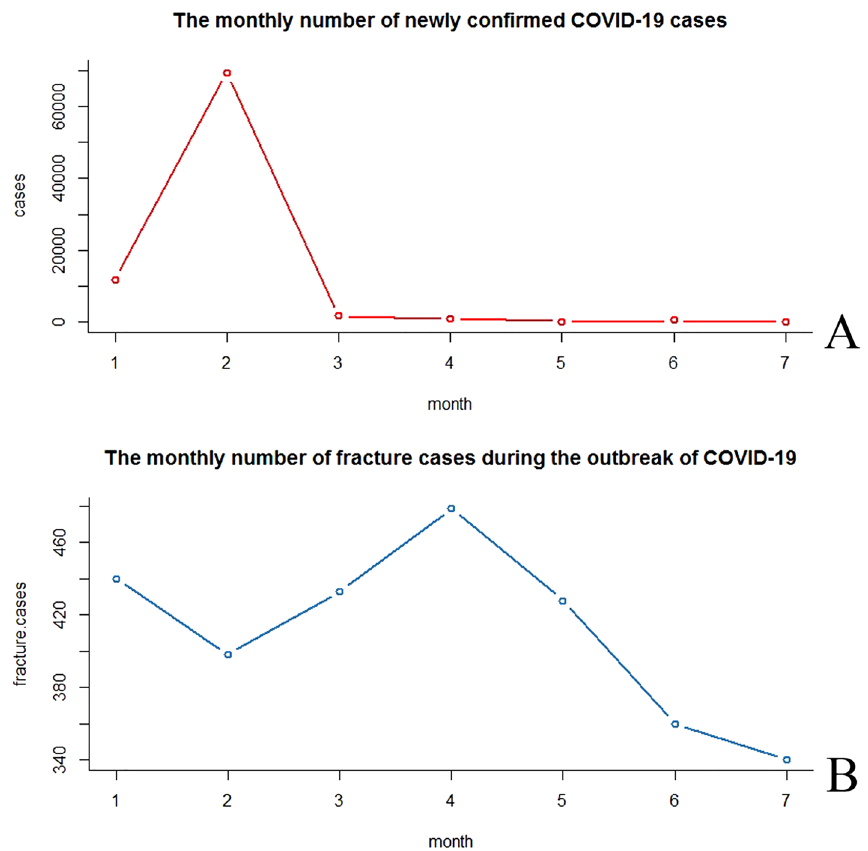
Figure 2. Monthly numbers of newly confirmed COVID-19 cases and fracture cases.